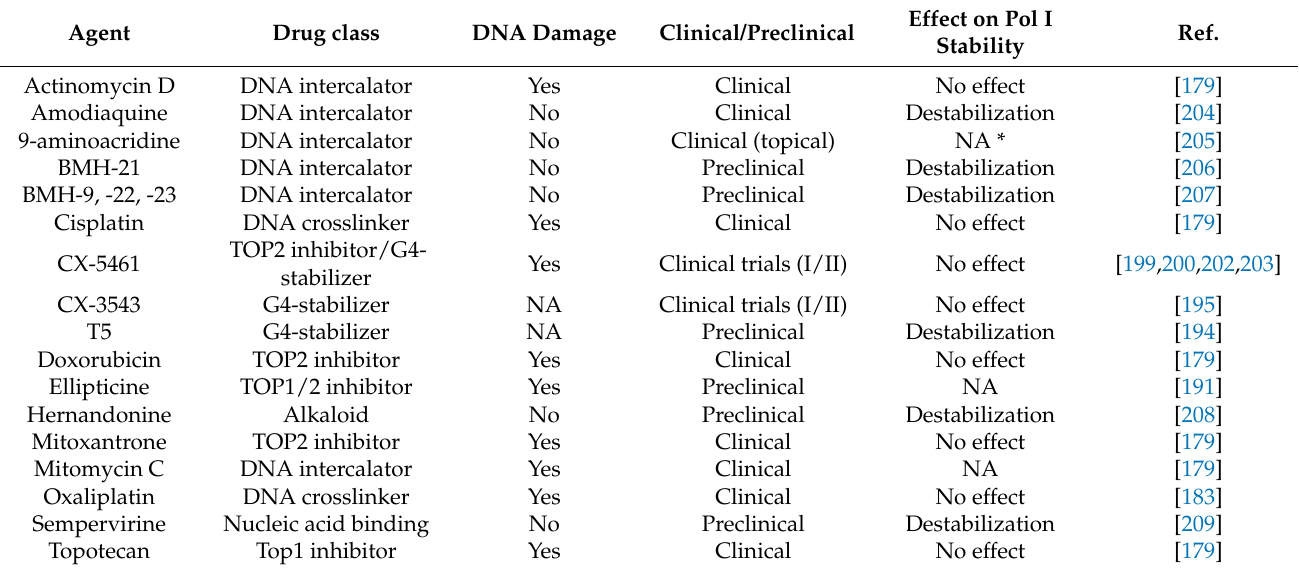
Table 1. Experimental and clinical agents inhibiting Pol I